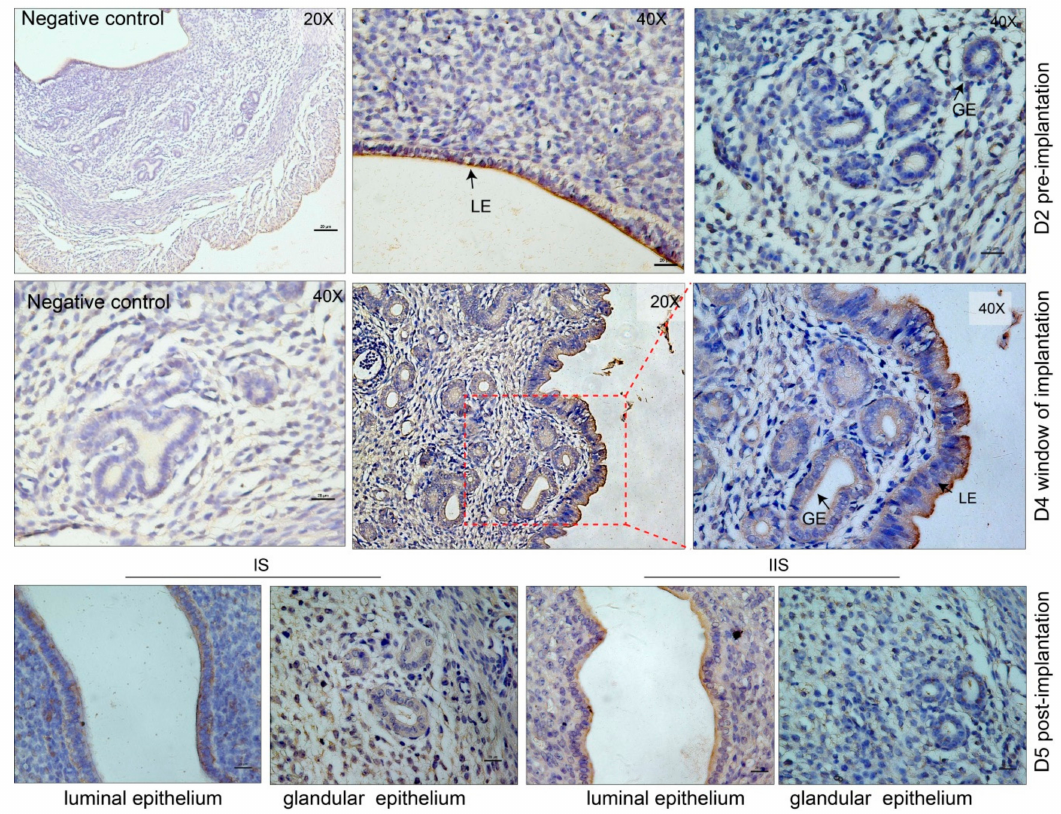
Figure 2. Immunohistochemical staining of CD63 in mouse glandular and luminal epithelium during pre-implantation (D2), window of implantation (WOI) (D4), post-implantation (D5) stage, and in the negative control (no primary antibody). LE: luminal epithelium. GE: glandular epithelium. IS: implantation site. IIS: inter implantation